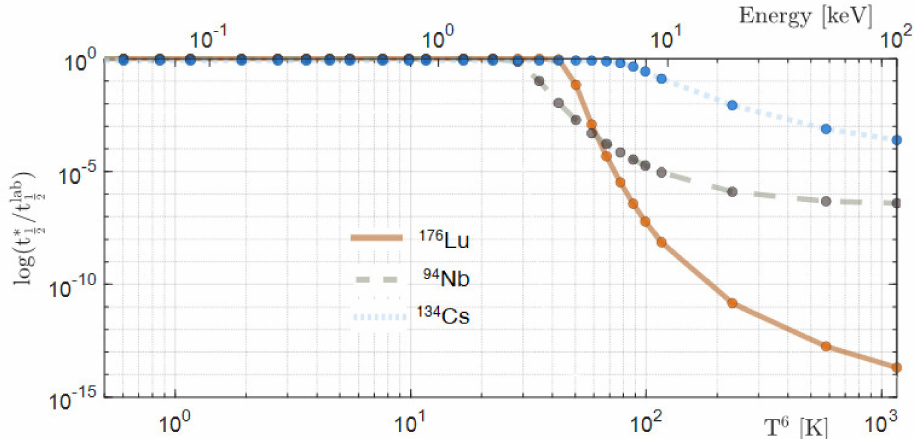
Figure 7. Theoretical estimates (based on [27]) of the 176 Lu, 134 Cs, and 94 Nb ratios of stellar half-life to terrestrial half-life dependence as a function of plasma temperature T6 [10 6 K] (Energy [keV]) at densities of PANDORA’s plasmas (10 12 cm − 3 ). The red line corresponds to the trend of 176 Lu. The dashed, gray line shows the trend of 94 Nb, while the blue, dotted line indicates the trend of 134